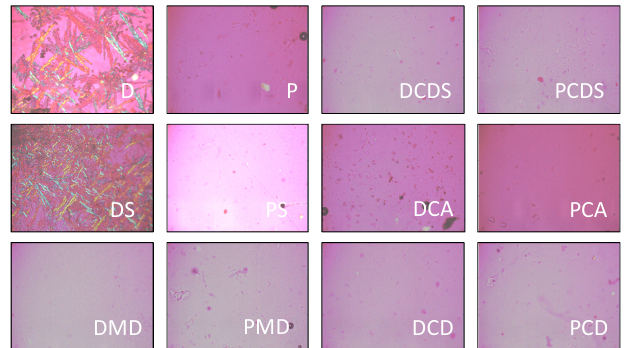
Figure 4. Polarized light microscopy: pictures of drug-free and drug-loaded films (batch codes according to Table 2).